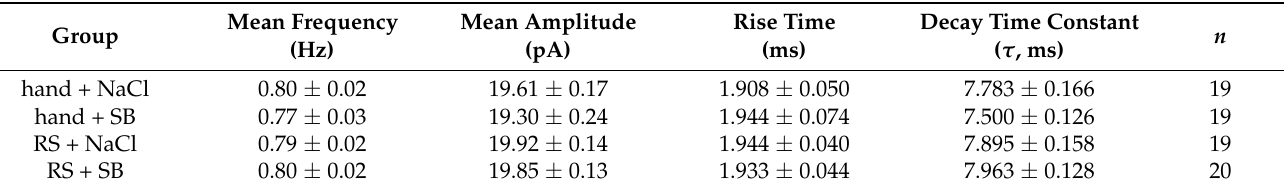
Table 6. Effects of restraint and SB 269970 on parameters characterizing sIPSCs (mean ± SEM).